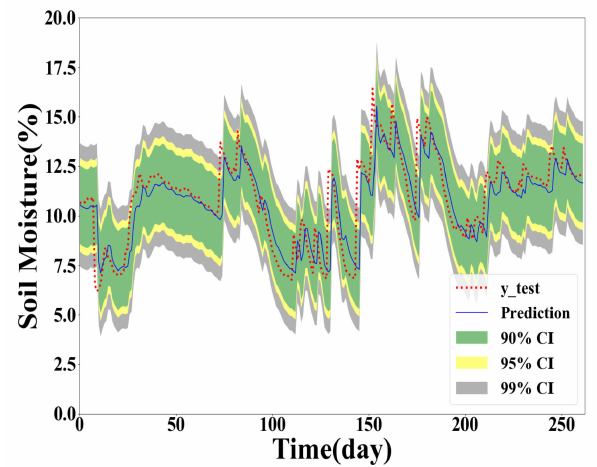
Figure 6. GPR model built with full training data in Y(2) prediction.